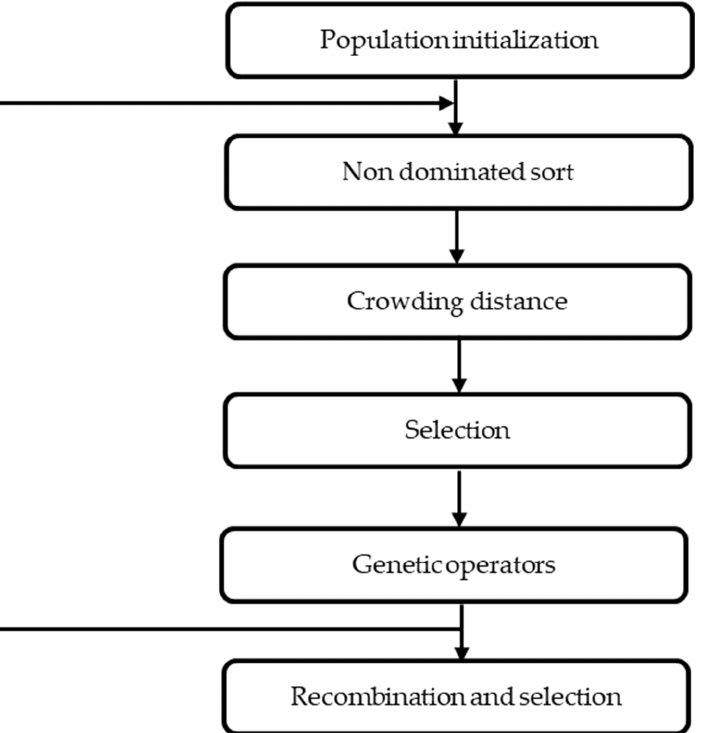
Figure 7. Different stages of NSGA-II algorithm are used to adequately circumscribe a large number of representative non-dominated solutions.